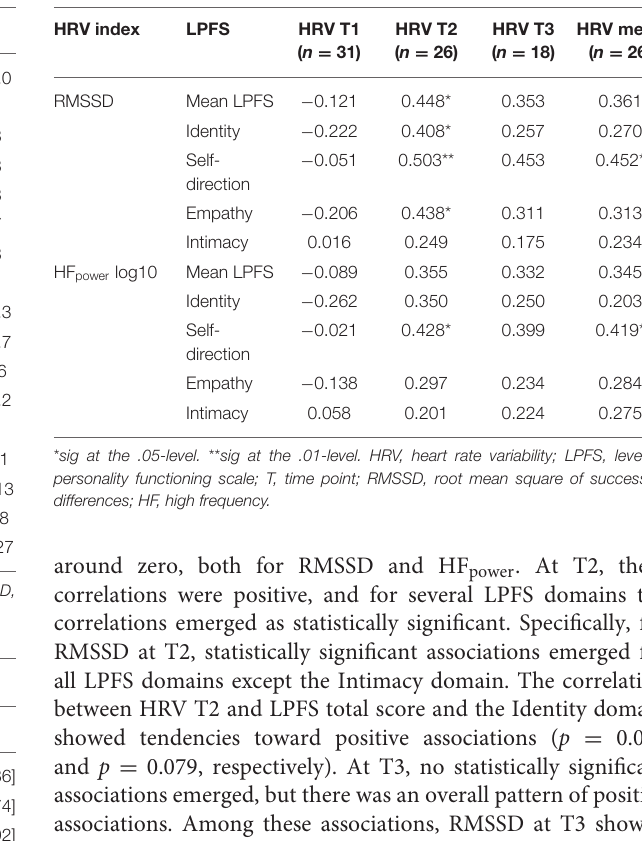
TABLE 3 | Pearson correlations between HRV indices and LPFS